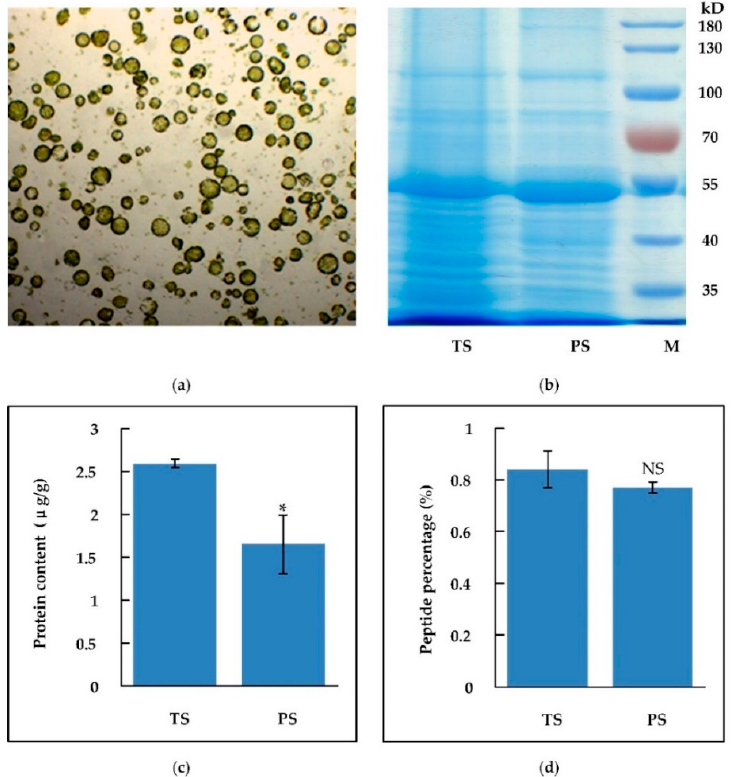
Figure 3. Peptides extracted from leaf tissue and protoplasts. ( a ) Protoplasts of Arabidopsis leaf; ( b ) total-protein (including peptides) yield extracted from tissues (TS) and protoplasts (PS); ( c ) total-protein (including peptides) content of tissues (TS) and protoplasts (PS); ( d ) peptide ( < 10 kD) proportion in total-protein of tissue (TS) and protoplast (PS). Asterisk (*) represents significant difference ( P < 0.05). NS represents no significant difference. Error bar represents the mean ± standard deviation (n =